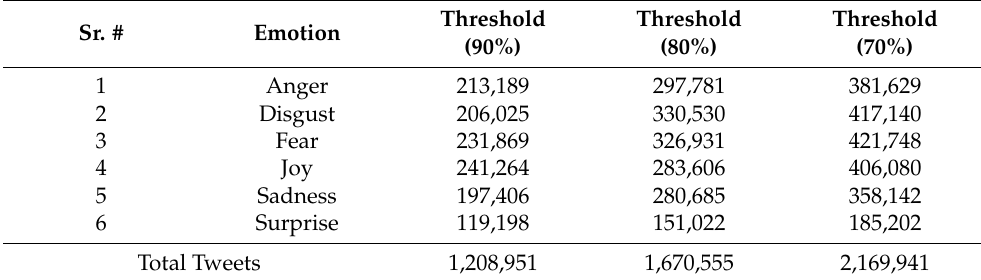
Table 7. Emotion tweets